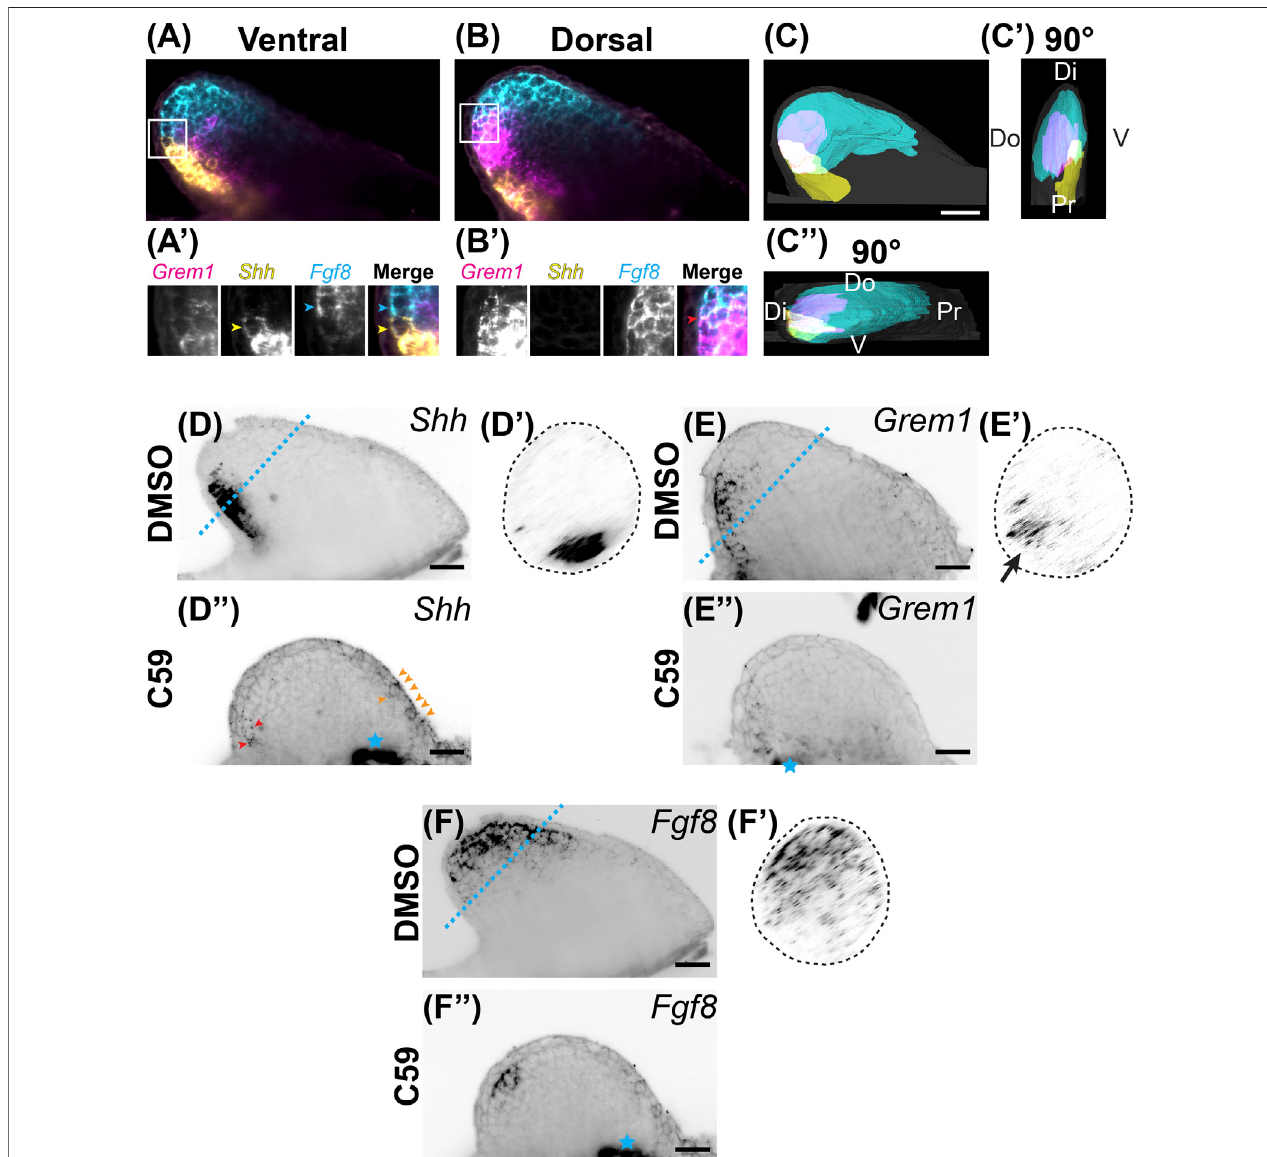
FIGURE 4 | Expression of Shh / Fgf8 / Grem1 in the developinglimb. (A) Light-sheet microscopyofHCR-FISH for Grem1 (magenta), Shh (yellow), and Fgf8 (cyan) in theventralregion. (A 9 ) Zoomed-inimagesoftheregionhighlightedbythewhiteboxin (A) .Noticethelackofoverlapbetweenthe Shh -expressingcellhighlightedwiththe yellow arrowhead and the Fgf8 -expressing cell highlighted with the cyan arrowhead. (B) A coronal optical slice collected from the dorsal region of the limb bud. (B 9 ) Images are close-ups of the boxed region in (B) . Notice the overlap in expression between Grem1 and Fgf8 . (C) Segmentation of Shh , Fgf8 , Grem1 expression domainsofthestage46limbbudshownin (A,B) .Scalebar:200 µm. (C 9 ) A90 ° rotationshowingadistal/posteriorviewofthelimb.Dorsal(Do),ventral(V),distal(Di),and proximal(Pr)regionsofthelimbarehighlighted. (C ” ) A90 ° rotationshowingadistal/anteriorviewofthelimb.Do,V,Di,andPrarehighlighted. (D) Singlez-planeimageof Shh expression in the stage 46 limb bud. (D 9 ) The cross sectional view of the blue dotted line in D. Notice the posterior/ventral expression domain. (D ” ) Shh expression after C59 treatment. Red arrowheads show the decrease of Shh expression in the posterior domain. Orange arrowheads indicate a new anterior expression domain in the mesenchyme and epithelium. (E) Grem1 expression in an untreated limb bud showing mesenchymal posterior expression. (E 9 ) Cross sectional view of the blue dottedlinein (E) , showingtheposterior/dorsal expression domain of Grem1 . (E ” ) Grem1expression after C59treatment showingastrong decline ingeneexpression in the posterior mesenchyme. (F) Fgf8 expression in the distal anterior mesenchyme of the limb bud. (F 9 ) Cross section of the blue dotted line in (F) showing the anterior mesenchymal expression of Fgf8 with a slight skew towards the dorsal portion of the limb bud. (F ” ) Fgf8 expression after C59 treatment shows a decrease in the expression domain except in the most posterior distal portion of the limb. The blue star indicates auto fl uorescence of the fl ank muscle.